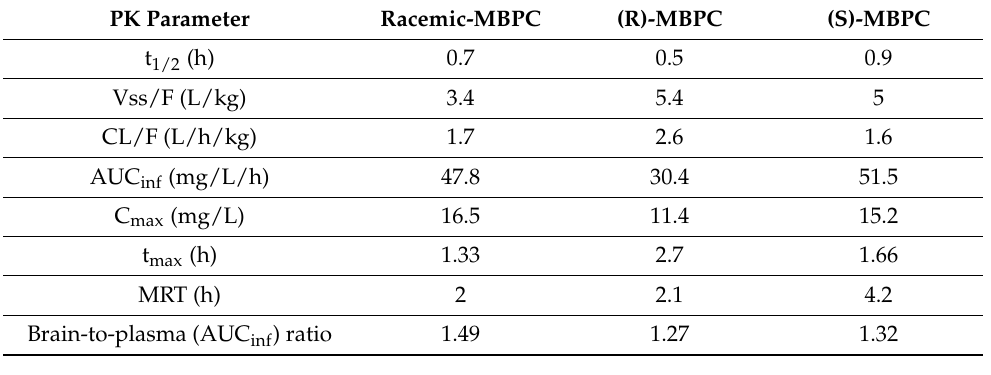
Table 2. Mean pharmacokinetic (PK) parameters of 3-methylpropyl(4-sulfamoylphenyl)carbamate (MBPC) (racemate) and its two individual enantiomers calculated from brain levels following i.p. (80 mg/kg dose) administration to rats.